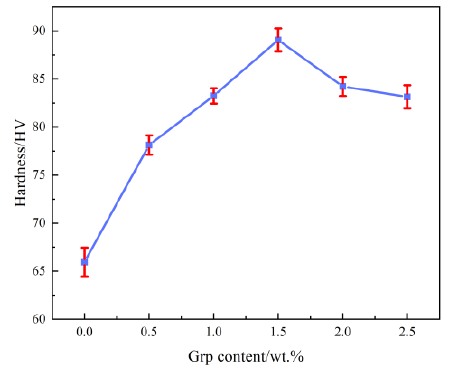
Figure 9. Variations in hardness with Grp content.